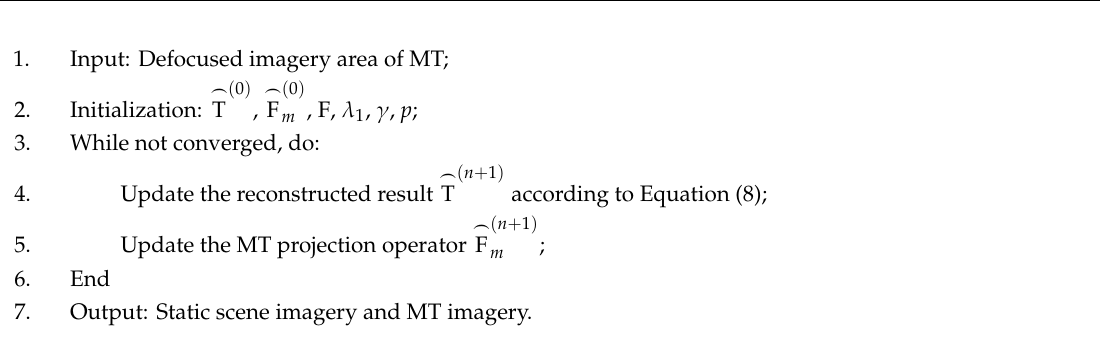
Algorithm 1: Joint sparse-based MT